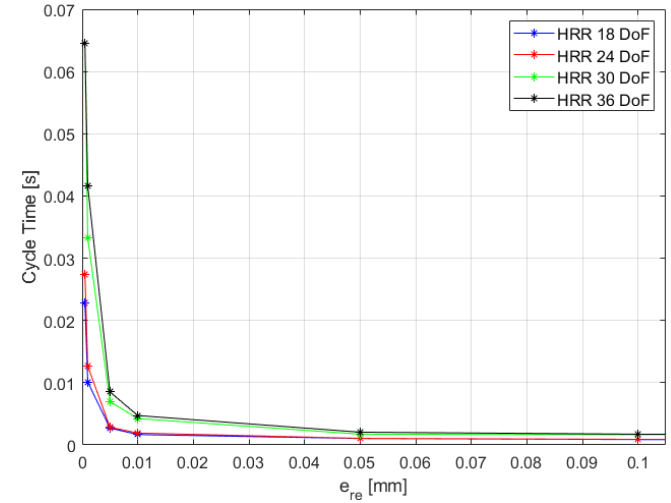
Figure 7. Cycle time variation for different 𝑒 𝑟𝑒 values.